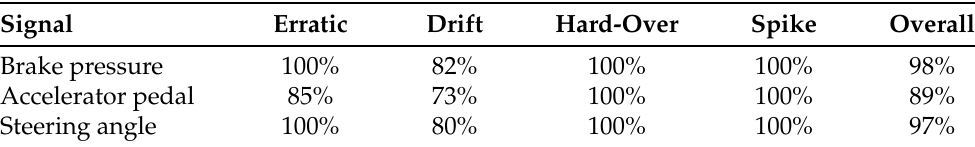
Table 9. Fault identification accuracy by multi-class